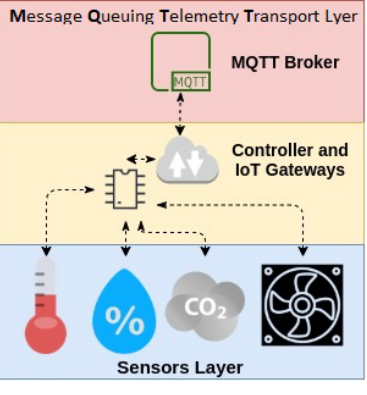
Figure 9. IoT Layer Architecture.